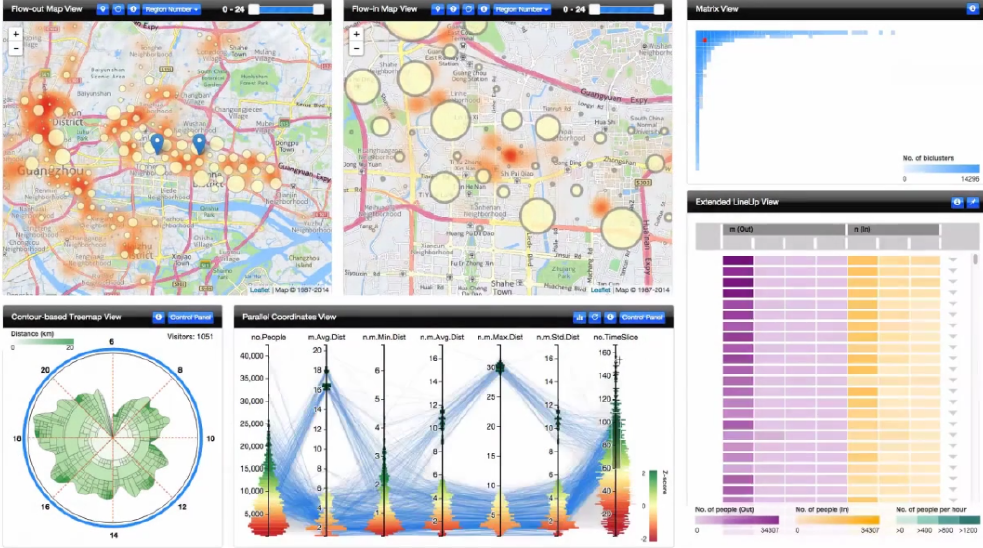
Figure 26. The TelCoVis visualization system for exploring co-occurrence [94] (extracted from